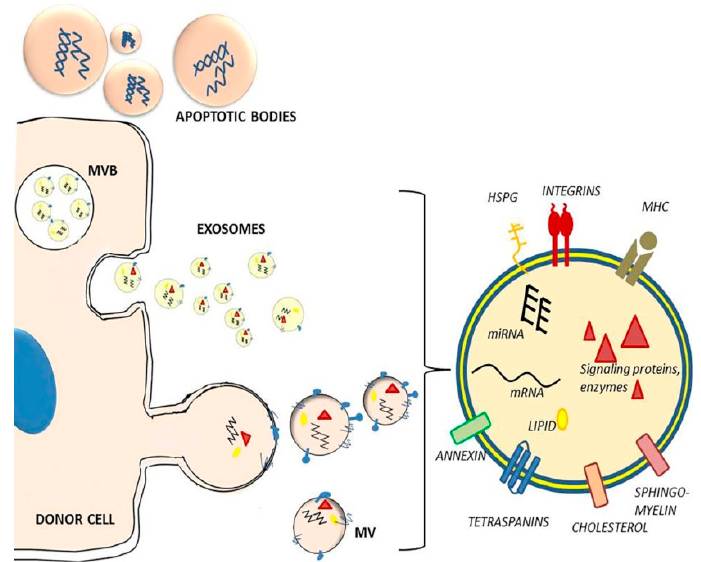
Figure 1. Types, release, and composition of extracellular vesicles. Based on their generation and size distribution EVs can be divided into exosomes, microvesicles, and apoptotic bodies. Exosomes are formed inside endosomes by inward budding of the membrane, generating multivesicular bodies (MVB). Exosomes are released by fusion of MVB with the plasma membrane. Microvesicles (MV) arise as a result of direct budding and fission of the plasma membrane from the cells. Apoptotic bodies are formed during apoptosis, from outward blebbing of the cell surface. EVs are composed of a phospholipid bilayer with membrane proteins (immuno-regulatory molecules such as MHCI, MHCII, integrins, tetraspanins, receptors, heparan-sulfate proteoglycans (HSPG), annexins, cholesterol, sphingolipids, ceramides), carrying soluble cytosolic components of the donor cell, such as miRNAs, mRNAs, signaling proteins, cytoskeletal proteins, enzymes, and lipids.